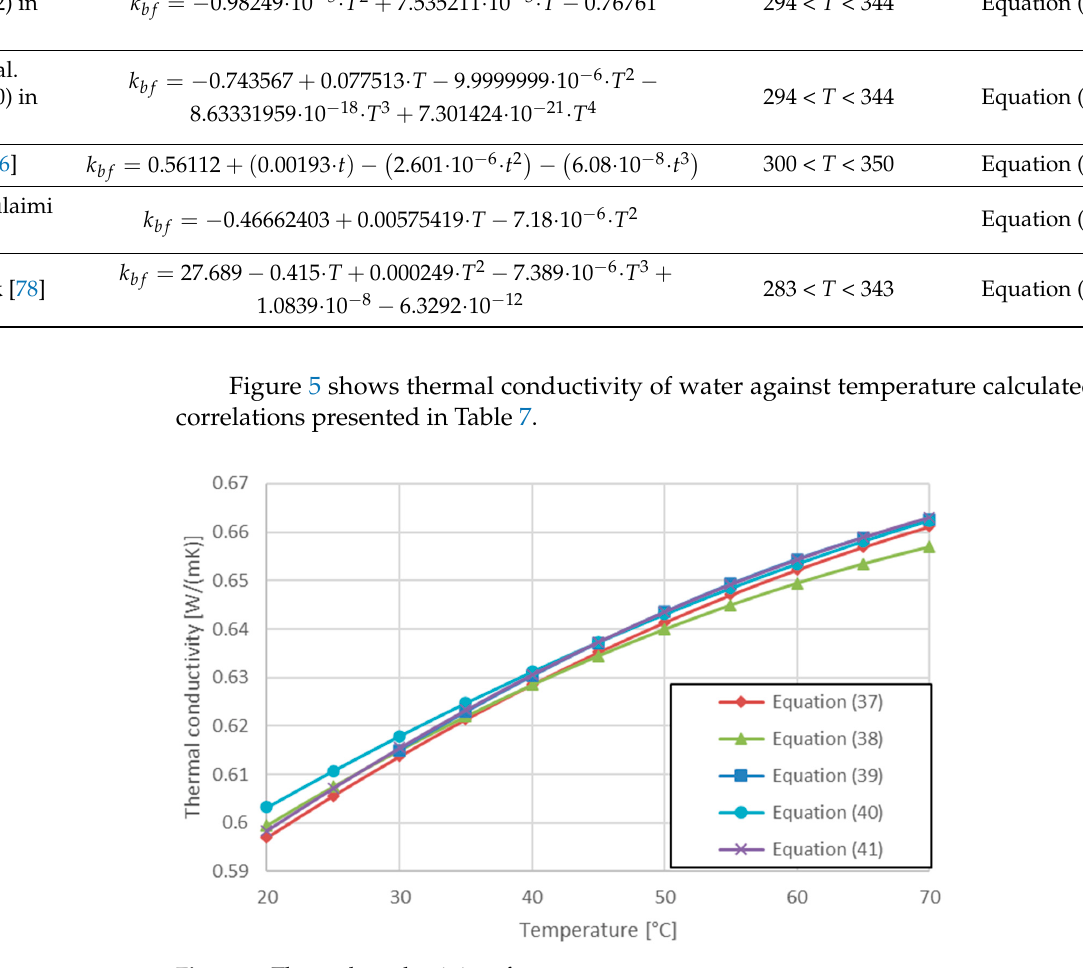
Figure 5. Thermal conductivity of water.